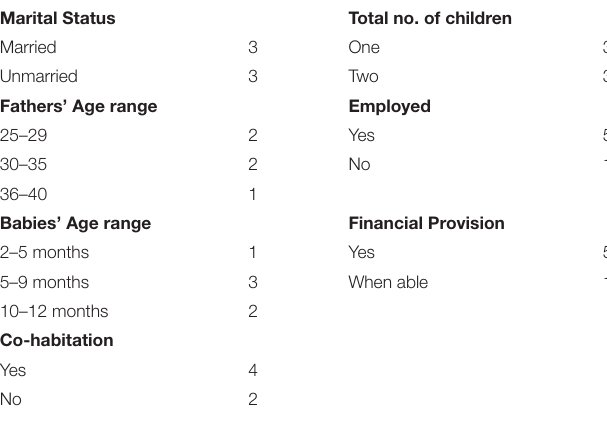
TABLE 1 | Brief demographic